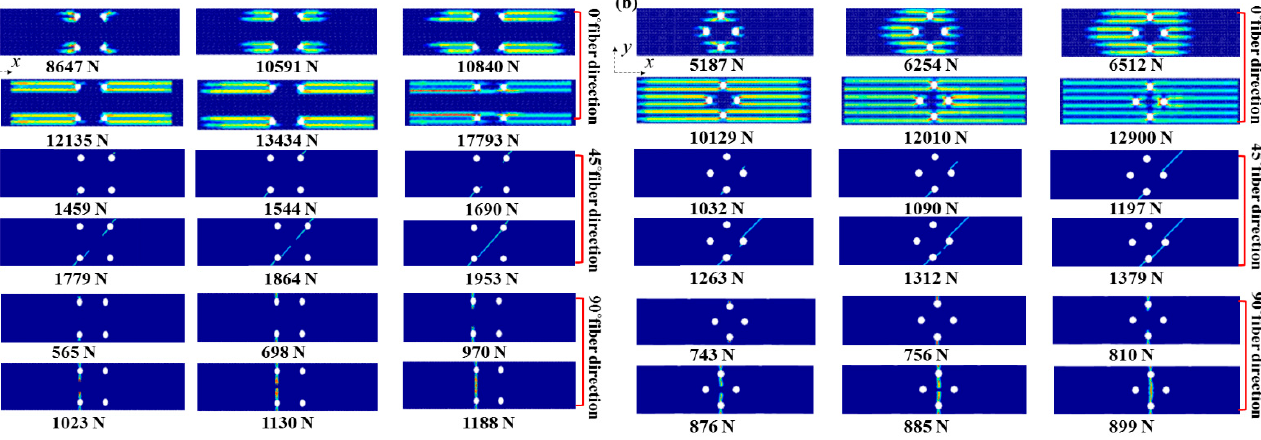
Figure 7. Unidirectional composite samples with ( a ) 0° fiber direction with different hole orienta- tions, ( b ) 90° fiber direction with different hole orientations, ( c ) 45° fiber direction with different hole orientations.